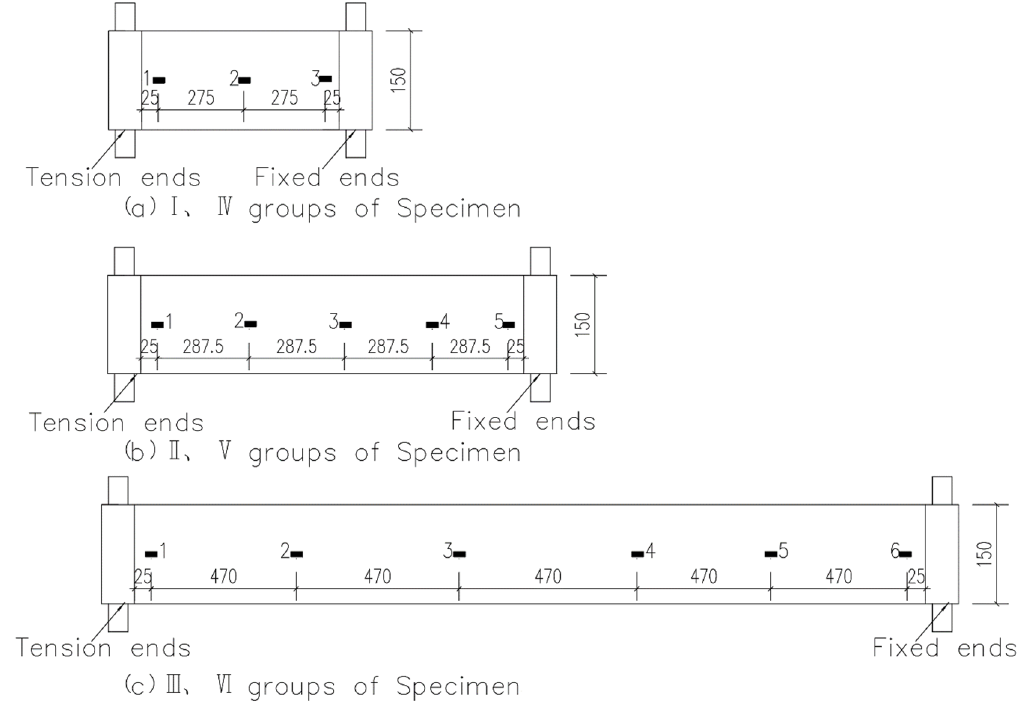
Figure 6. ( a – c ) Schematic of strain gauge arrangement on fiber (unit: mm).